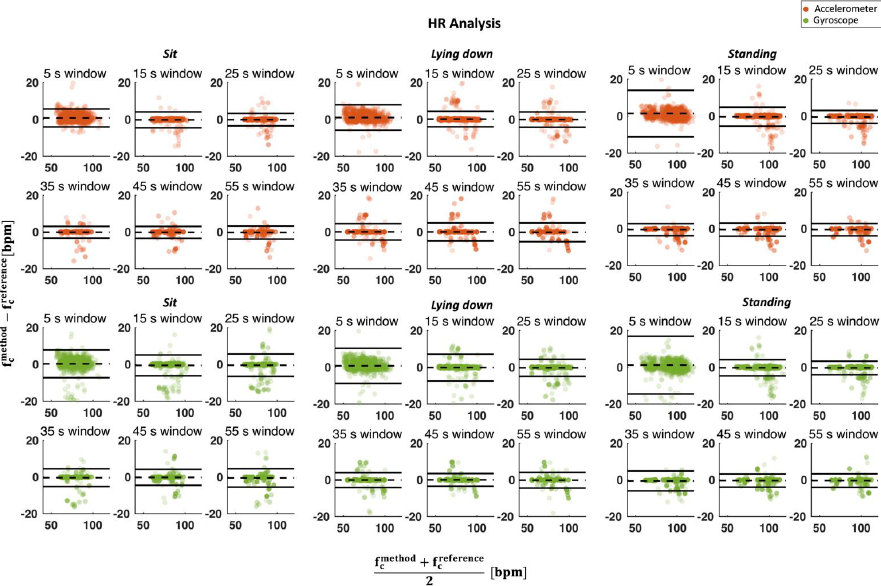
Figure 6. Bland – Altman plot for HR estimation considering all postures from both 𝑎 (in orange) and ω (in green) signals against reference. The dotted line in the figure represents the MOD, while the solid lines represent the LOA values. In each graph, the number of points is equal to the number of subjects multiplied by 120 (i.e., the duration of the test) minus the length of the window. For example, for the 5 s window, there will be 1256 points for 𝑎 and 1256 points for ω.